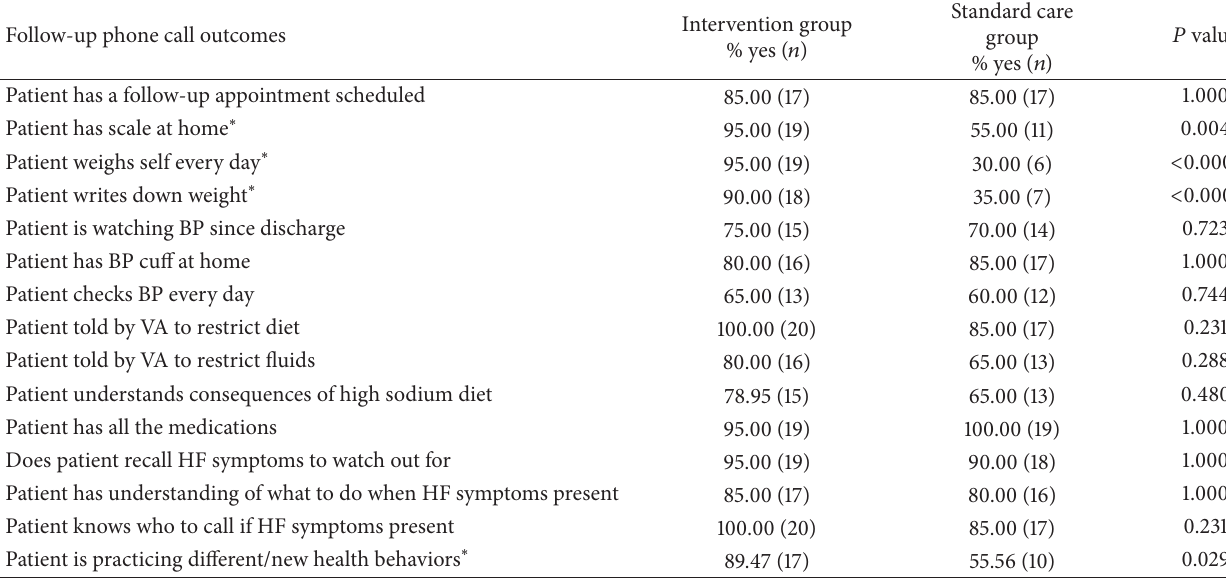
Table 3: Result of postdischarge phone call questions relative to study